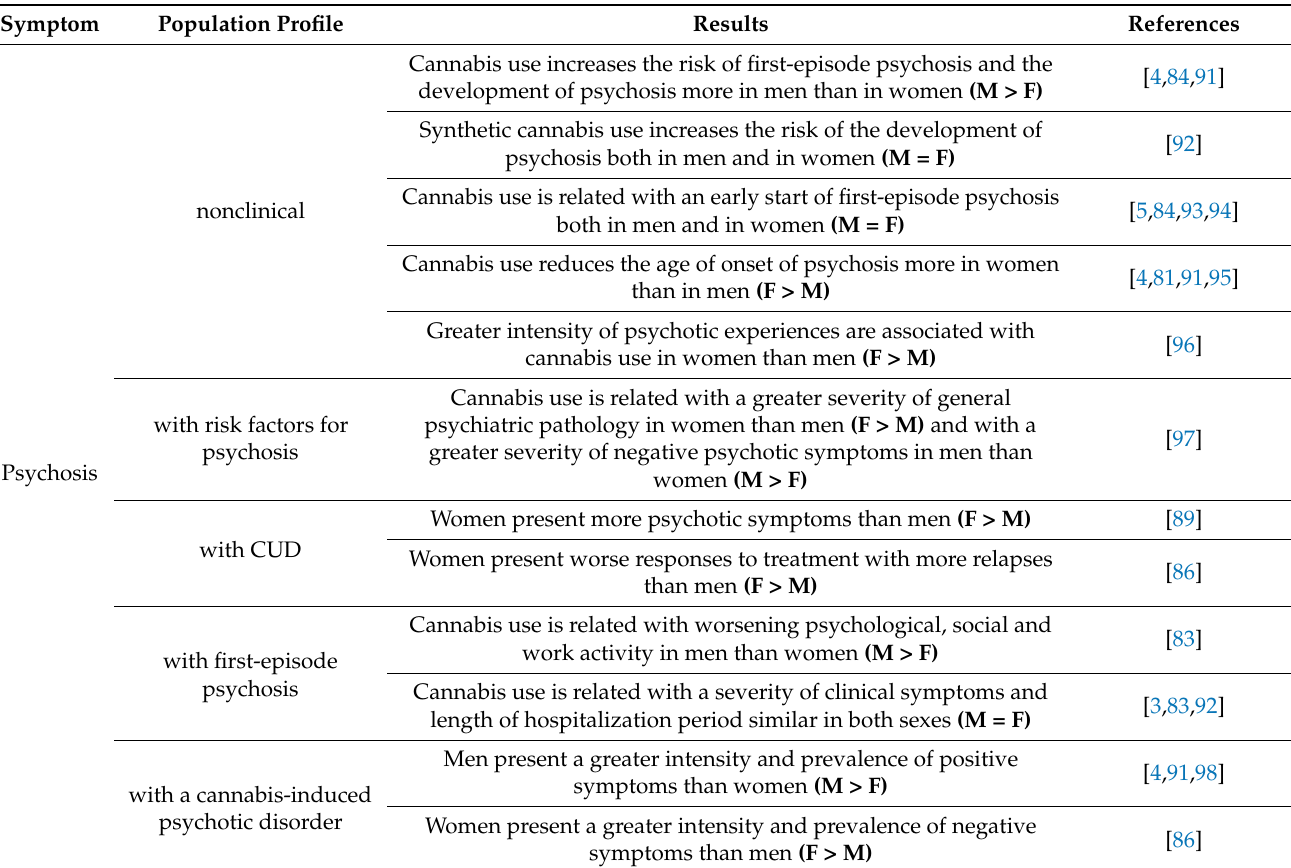
Table 1. The most important findings to date from the human literature on gender differences in the association between cannabis use and the development of psychotic, depressive and anxious symptoms. M: male; F: female; CUD: cannabis use